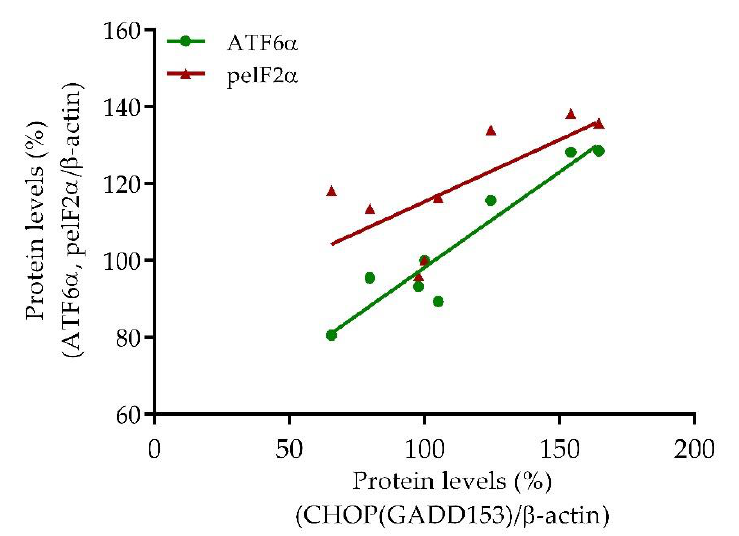
Figure 6. Correlations between protein levels of peIF2α and CHOP (red triangle) and of ATF6α and CHOP (green dot) in J774A.1 mouse macrophages pre-treated with increasing concentrations (2.5%, 5%, 10% v / v ) of SE FAE and subsequently stimulated or not with LPS.